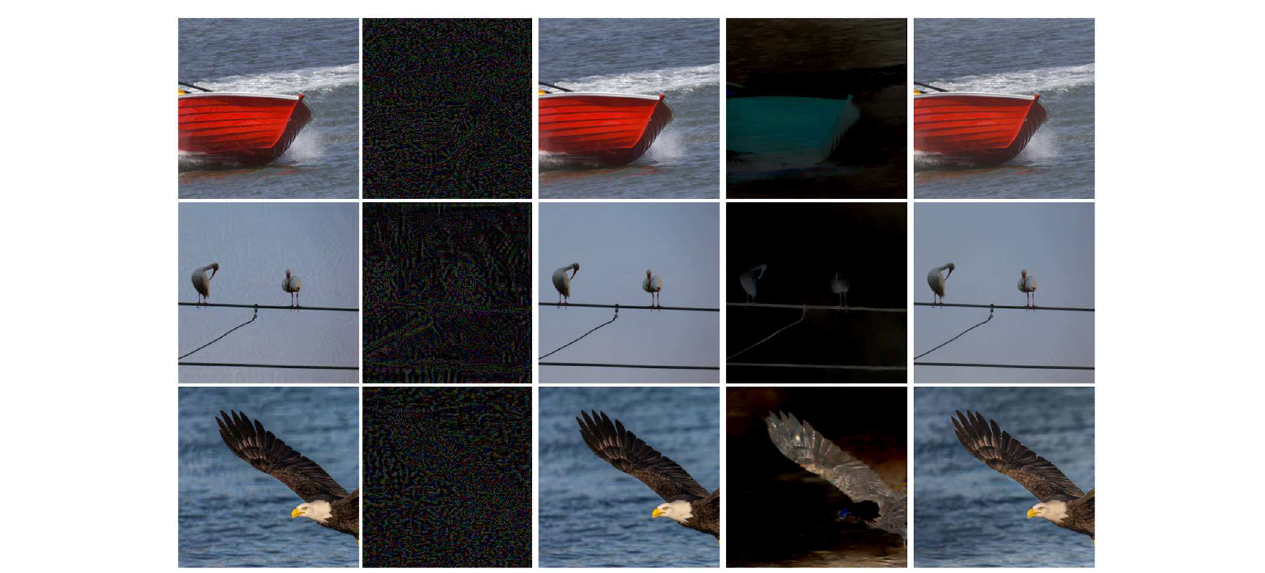
FIGURE1 The adversarial examples generated by the MI-FGSM ( Aydin et al., 2021) and the proposed DualFlow for the ResNet-152 (He et al., 2016) model. Specifically, the first column and the second column are the adversarial examples and their corresponding adversarial perturbations generated by MI-FGSM, respectively. The middle column is the clean images. The last two columns are the adversarial perturbations and their corresponding adversarial examples,